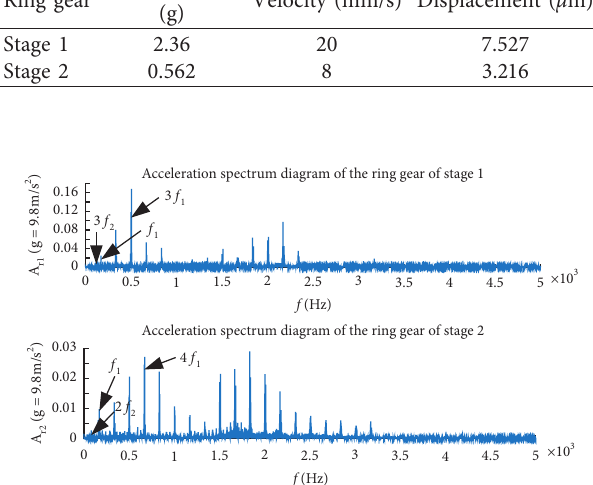
Figure 14: Vibration acceleration-frequency spectrum of the ring gear.